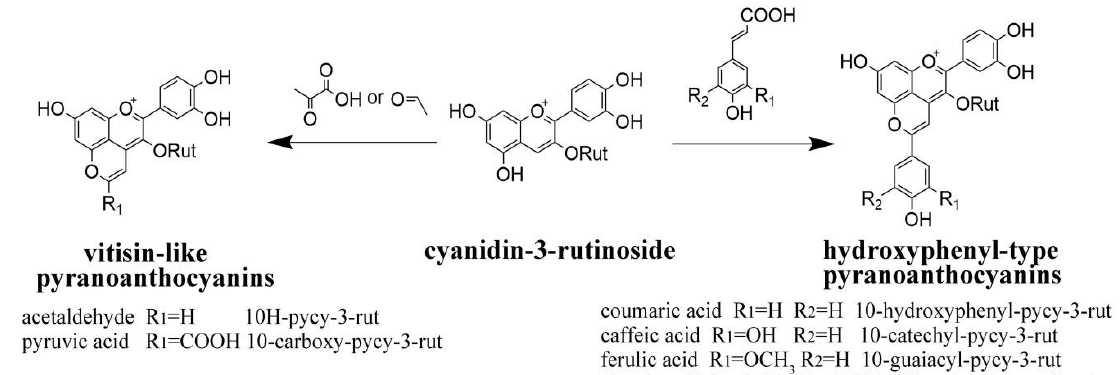
Figure 6. Pathway of formation of pyranoanthocyanins (abbreviations: py = pyrano, cy = cyanidin, rut = 3-O-rutinoside).